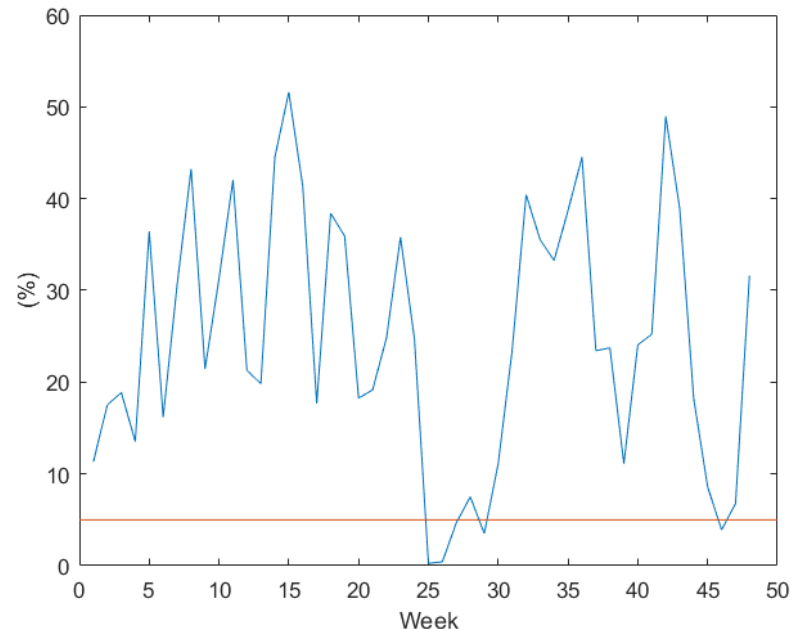
Figure 8. The amount of 10 s average values of the frequency per week outside the range 49 to 51 Hz. The straight line represents the 5% limit in EN 50160.